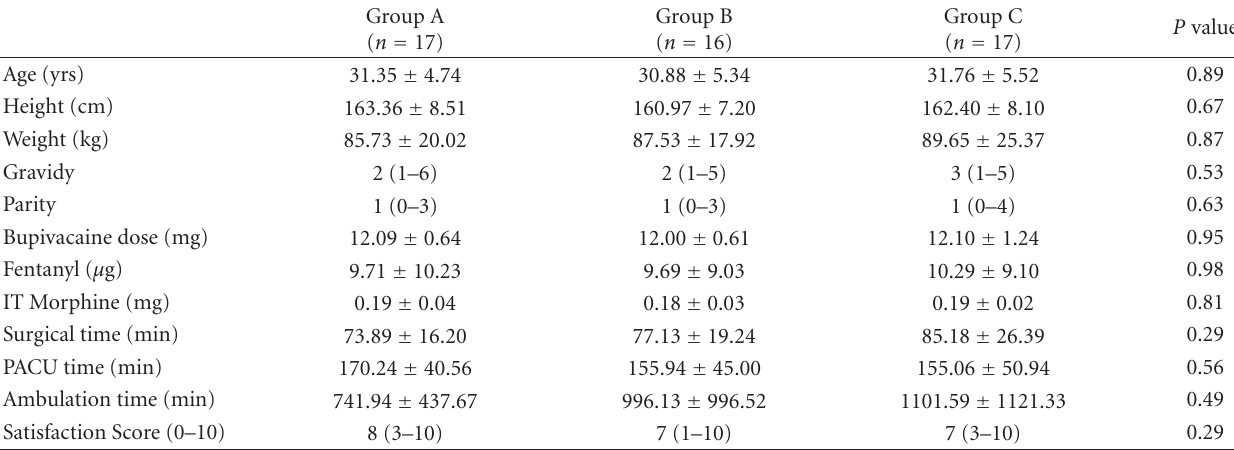
Table 1: Demographic, block characteristics, and maternal outcome data.